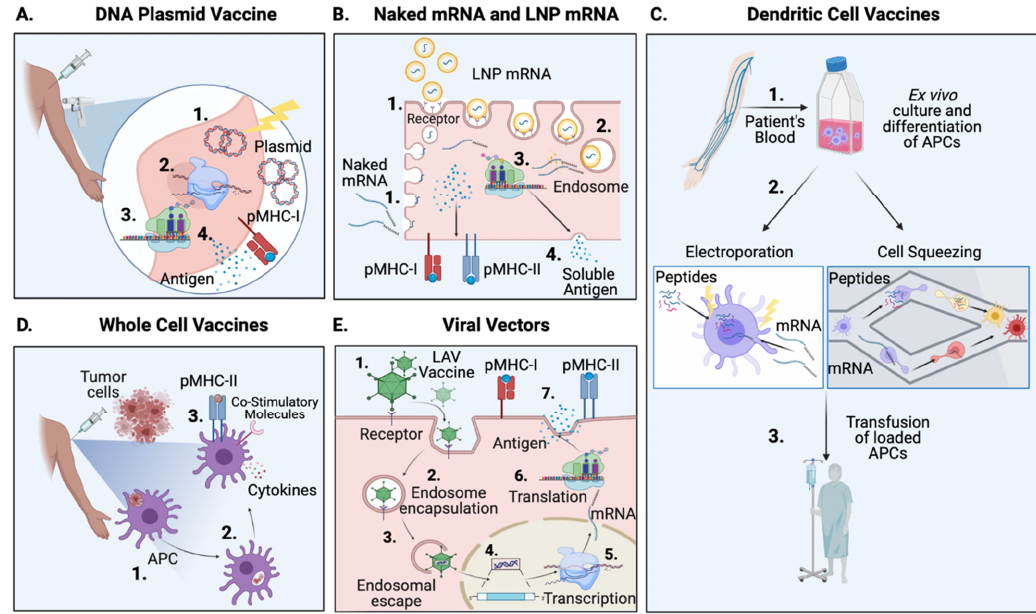
Figure 2. Cancer vaccine delivery methods . Various delivery strategies used to expose patients to immunogenic tumour antigens. ( A ) DNA Plasmid Vaccine. (1) DNA plasmids encoding cancer antigens are injected intramuscularly or pushed into myocytes using electrical pulses from a gene gun. (2) The host cells transcribe and (3) translate the given tumour antigens. (4) Tumour antigens peptides will be presented to immune cells on MHC-I molecules or alternatively secreted and then taken by APCs. ( B ) Naked mRNA and Lipid Nanoparticle (LNP) mRNA. (1) LNP mRNA is delivered to host cells via systemic or intramuscular injection and uptaken by the cells through specific ligand/receptor interactions. Naked